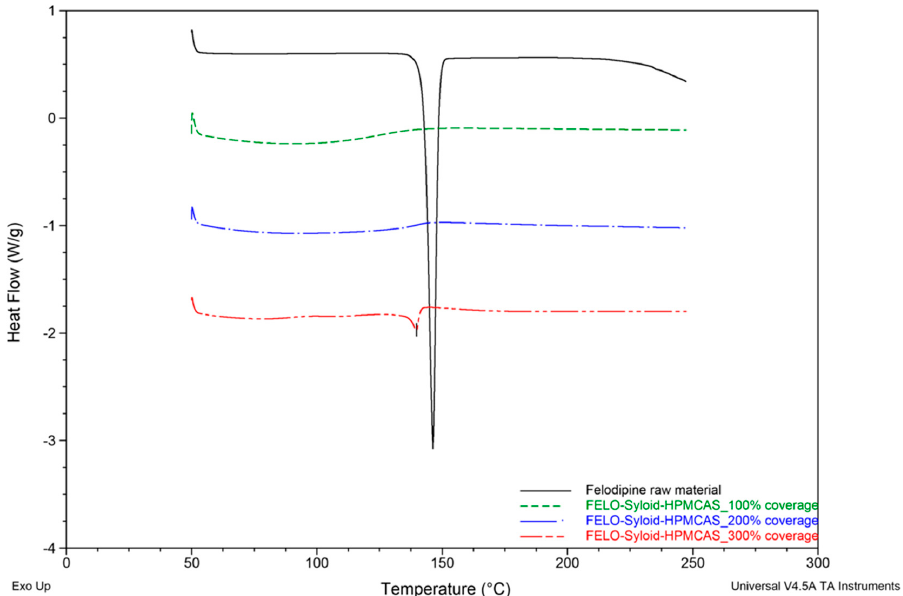
Figure 8. DSC thermograms of raw Felodipine material and FELO-Syloid-HPMCAS at various drug loads. Scanning rate: 10 ◦ C / min. Scanning range: 50–250 ◦ C.